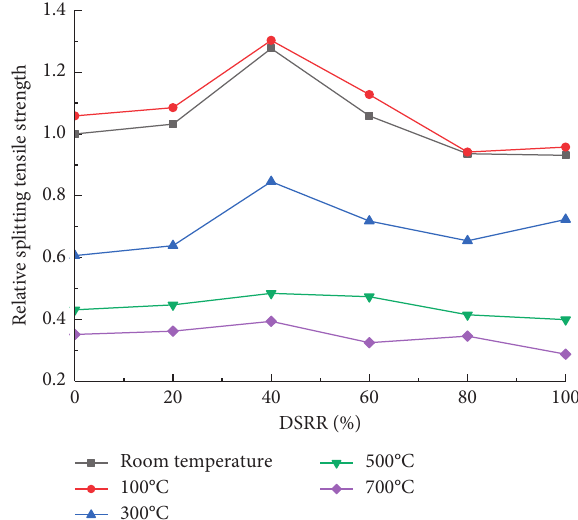
Figure 14: Relation between relative splitting tensile strength and